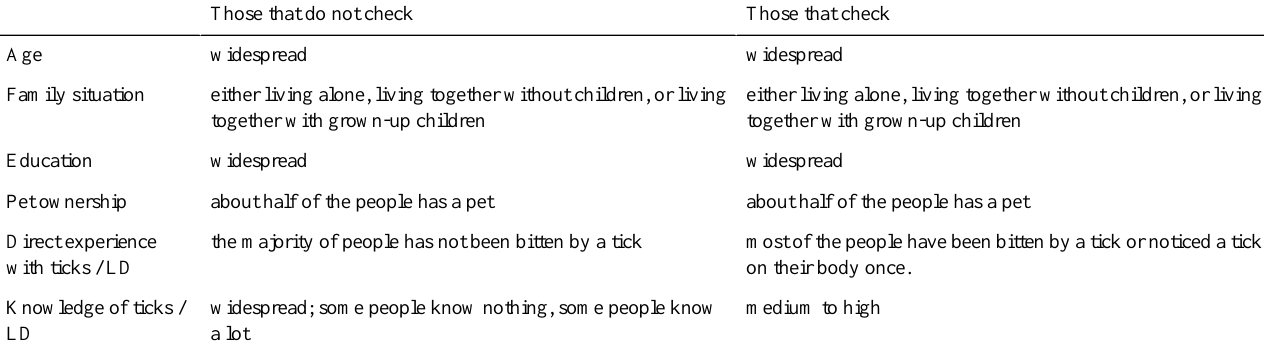
Table 1. Characteristics of outdoor